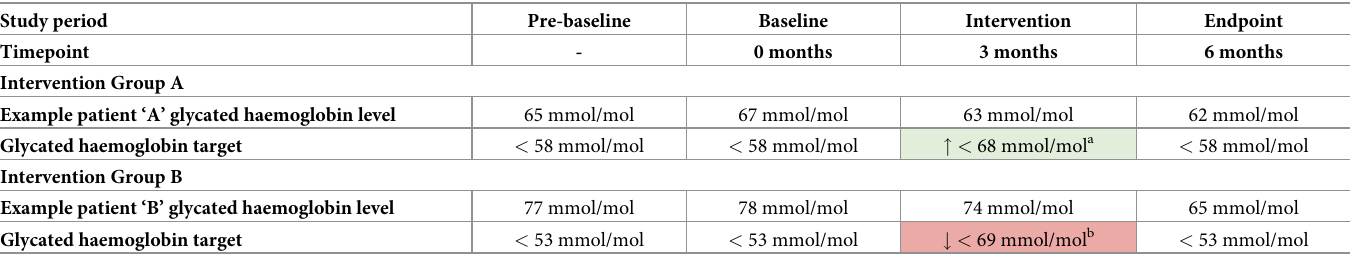
Table 2. Worked example of sub-study A intervention.